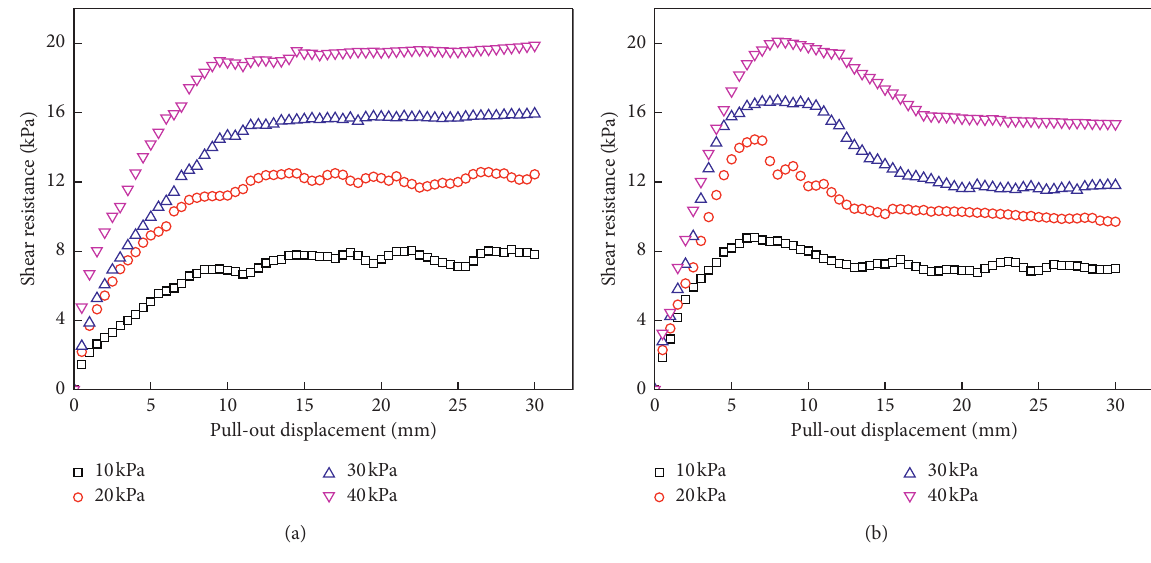
Figure 5: Pull-out test curves between geosynthetics and tailings: (a) geogrid and (b) geotextiles.